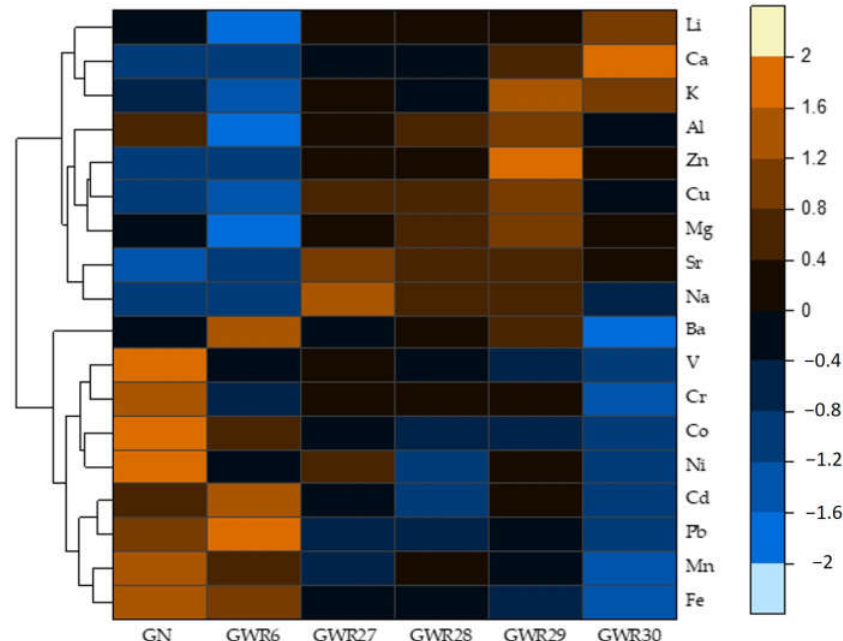
Figure 3. Logarithmic (Log10) values of Li in comparison with other macro- and microelements presented in heatmap with hierarchical clustering dendrogram of elements in soil samples from GN, GWR6, GWR27, GWR28, GWR29, and GWR30 sampling sites.